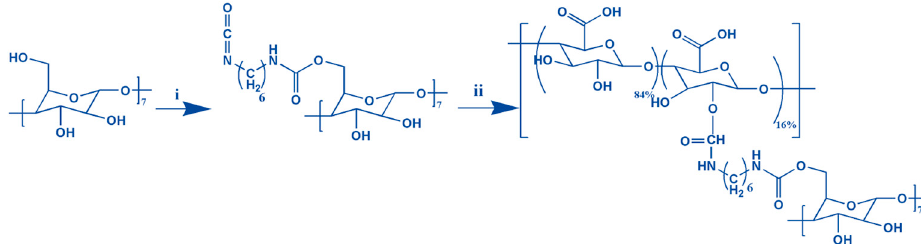
Figure 1. The formation of the Alg-CD schematic shows synthesis from the combination of CD- hexamethylene diisocyanate (i) and alginate (ii).